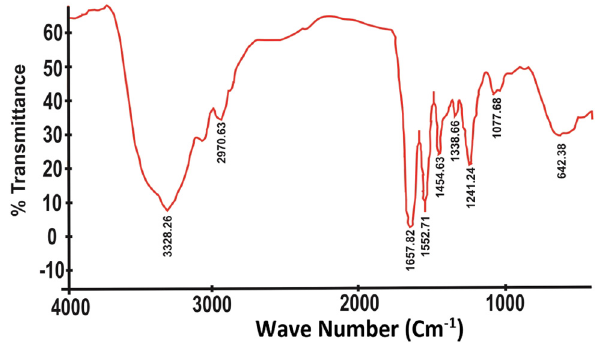
Figure 6: FTIR of pure collagen [ 17 ] .